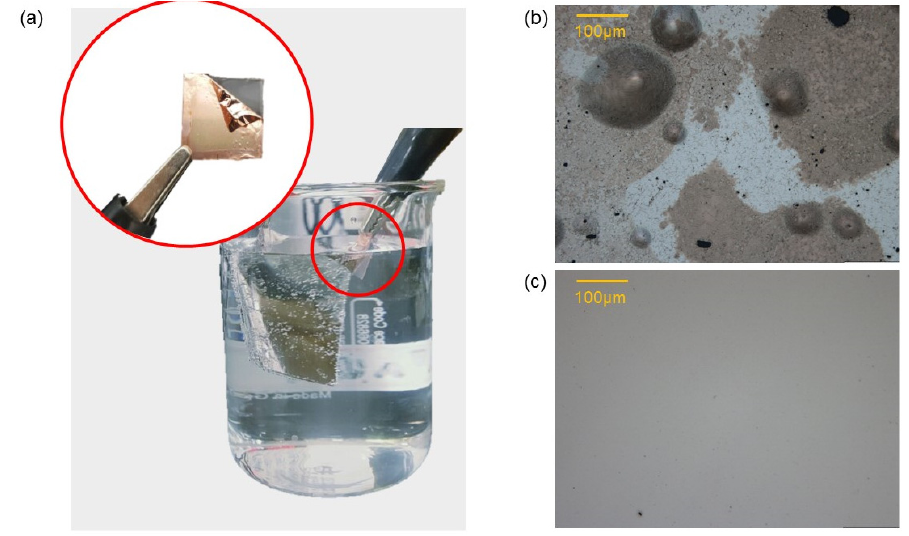
Figure 3. ( a ) Image of bubble transfer method for Sapphire/Cu and Cu which was detached from sapphire. ( b , c ) OM images of Sapphire/Cu and Sapphire/Cr/Cu after bubble ‐ transfer.